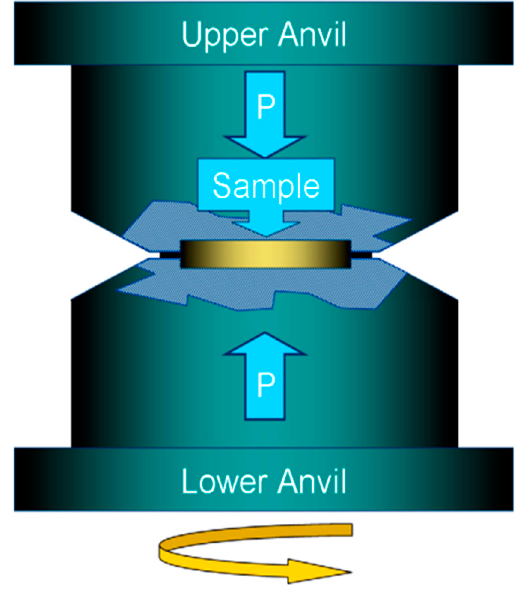
Figure 5. Schematic illustration showing the principles of high-pressure torsion (HPT).